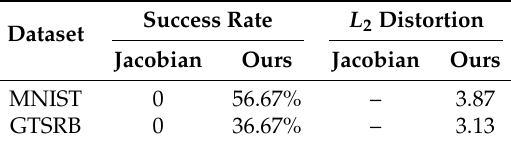
Table 4. Effect of targeted attack.